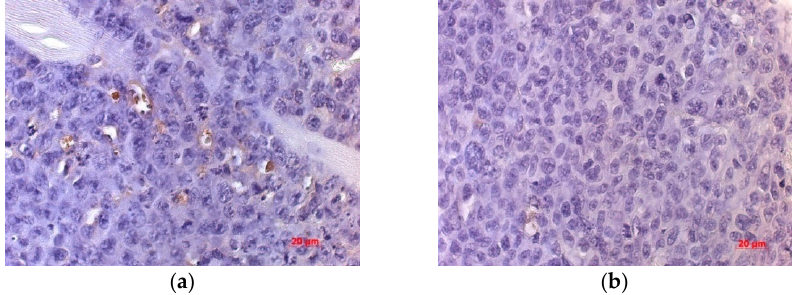
Figure 9. Immunohistochemical assay with the VEGFR marker in endothelial cells in mice tumor tissue without virotherapy ( a ) and after a course of virotherapy ( b ) on the 20th day after the course of injections (28th day of tumor growth), 63× magnification.